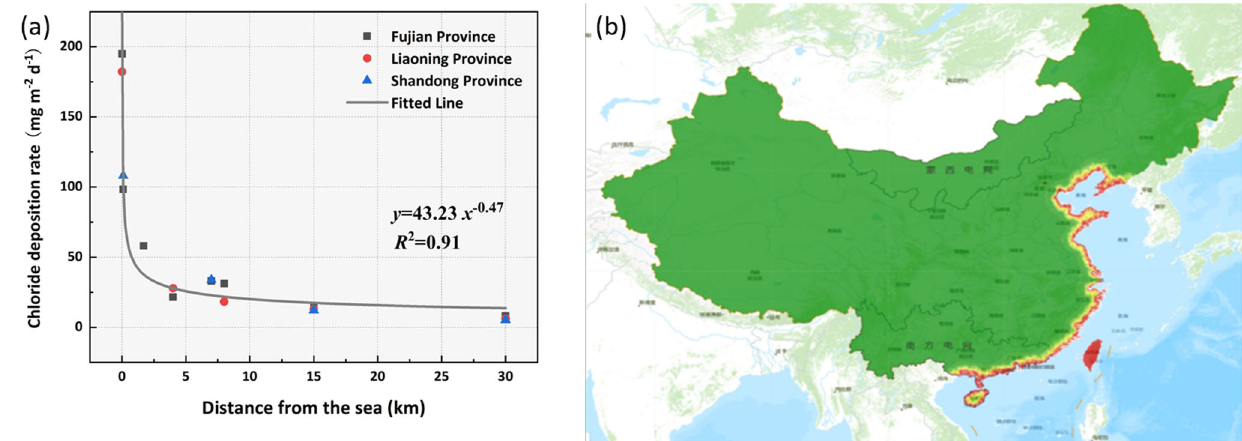
Fig. 4 The change of chloride ion distribution in coastal region. a the chloride ion diffusion model; b the chloride ion distribution map of coastal region in China.